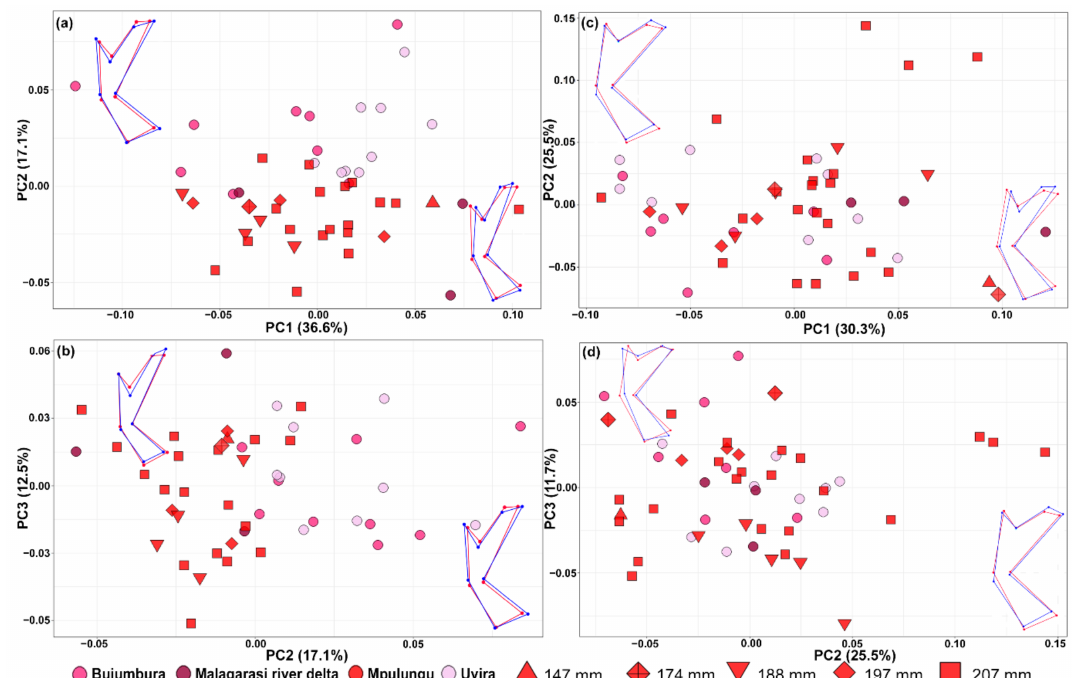
Figure 2. Biplots showing the shape variation in anchors of Cichlidogyrus casuarinus ex Hemibates stenosoma ; shape changes along each PC are shown by wireframes with starting shapes (consensus, value 0) in red, and target shapes (changes) associated with extreme values (value +0.1) in dark blue. Only the first three axes are shown. ( a , b ) PCAs based on Procrustes distances of eight fixed landmarks describing the shape of the dorsal anchor. ( c , d ) PCAs based on Procrustes distances of eight fixed landmarks describing the shape of the ventral anchor.